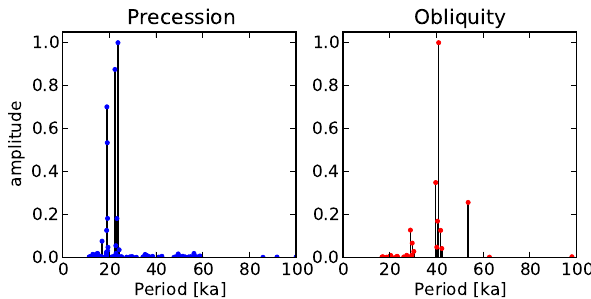
Fig. 2. Spectral decomposition of precession and obliquity given by Berger (1978), scaled here such that the strongest components have amplitude